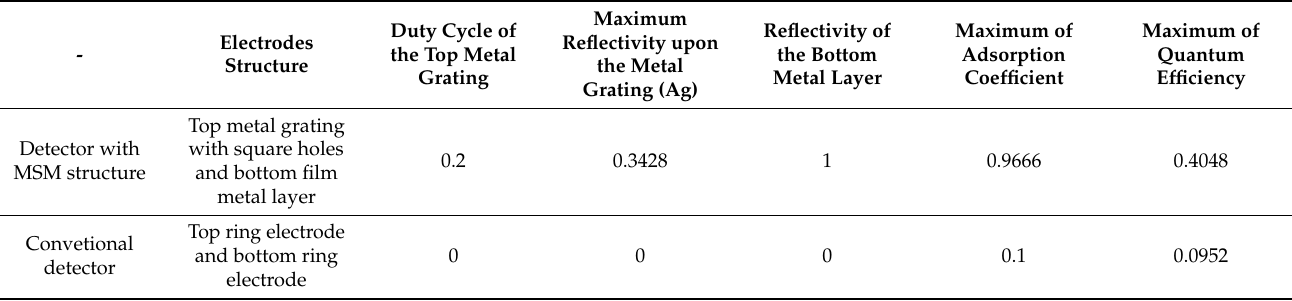
Table 1. Comparisons between the two detectors.